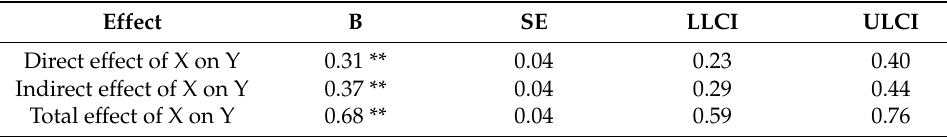
Table 4. Regression analysis of the mediating effect.